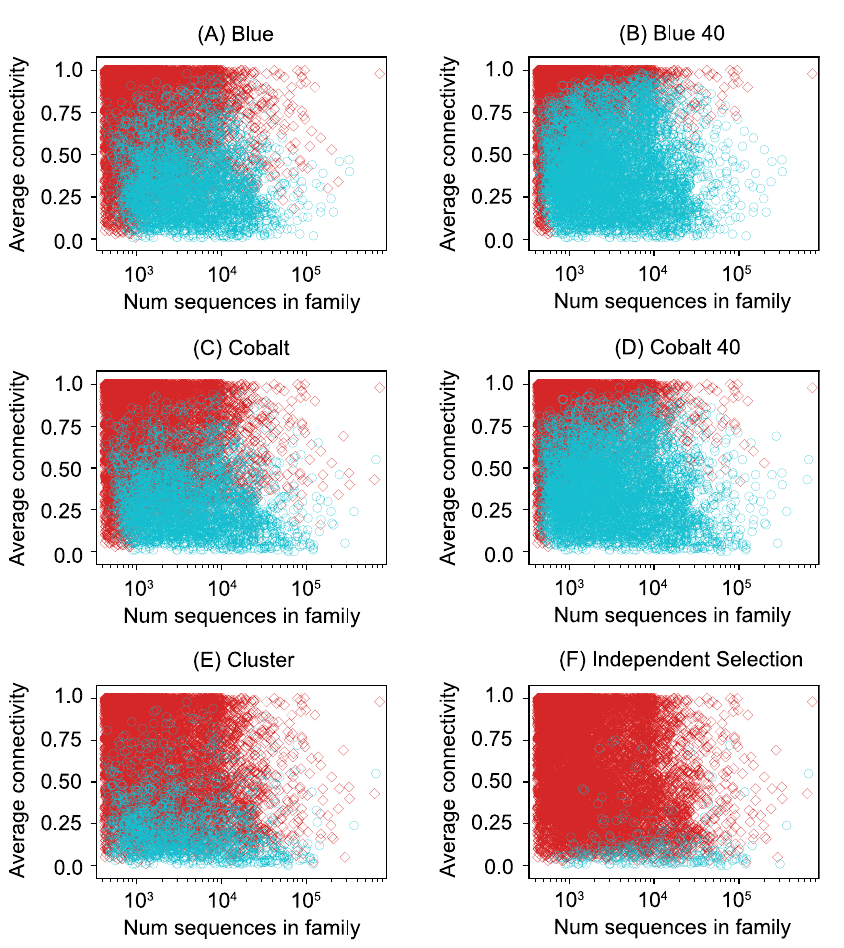
Fig 2. Characteristics of Pfam full families successfully split. Each marker represents a family in Pfam. The connectivity of a sequence is the fraction of other sequences in the full family with at least 25% pairwise identity. Families successfully split into a training set of size at least 400 and a test set of size at least 20 are marked by a cyan circle, whereas families that were not split are marked by a red diamond. In (B) and (D) the cyan circle represents at least one successful split among 40 independent runs. The 34 families that Blue did not finish splitting within 6 days are not included in the Blue plots.